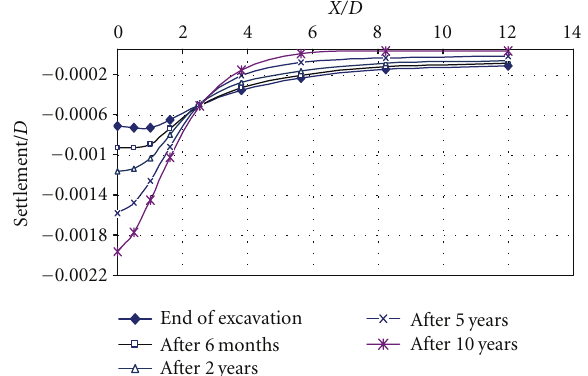
Figure 17: Surface horizontal displacement at the end of excavation and di ff erent times of consolidation using MCC soil model.